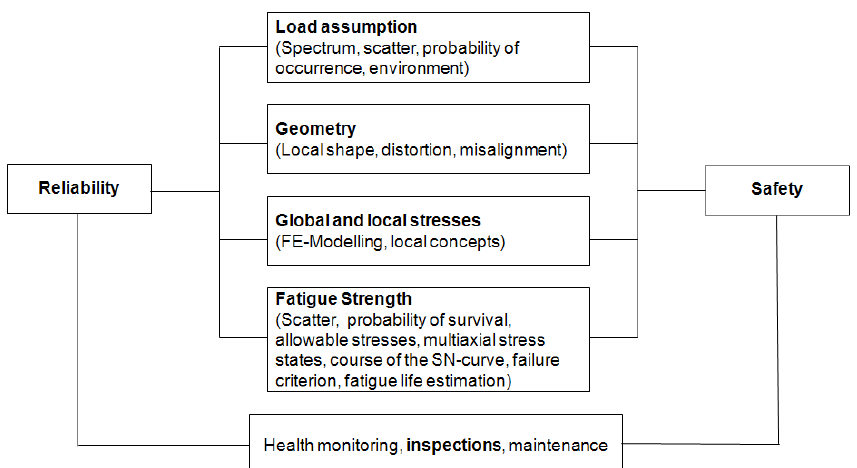
Figure 2: Reliability and safety aspects in fatigue design.